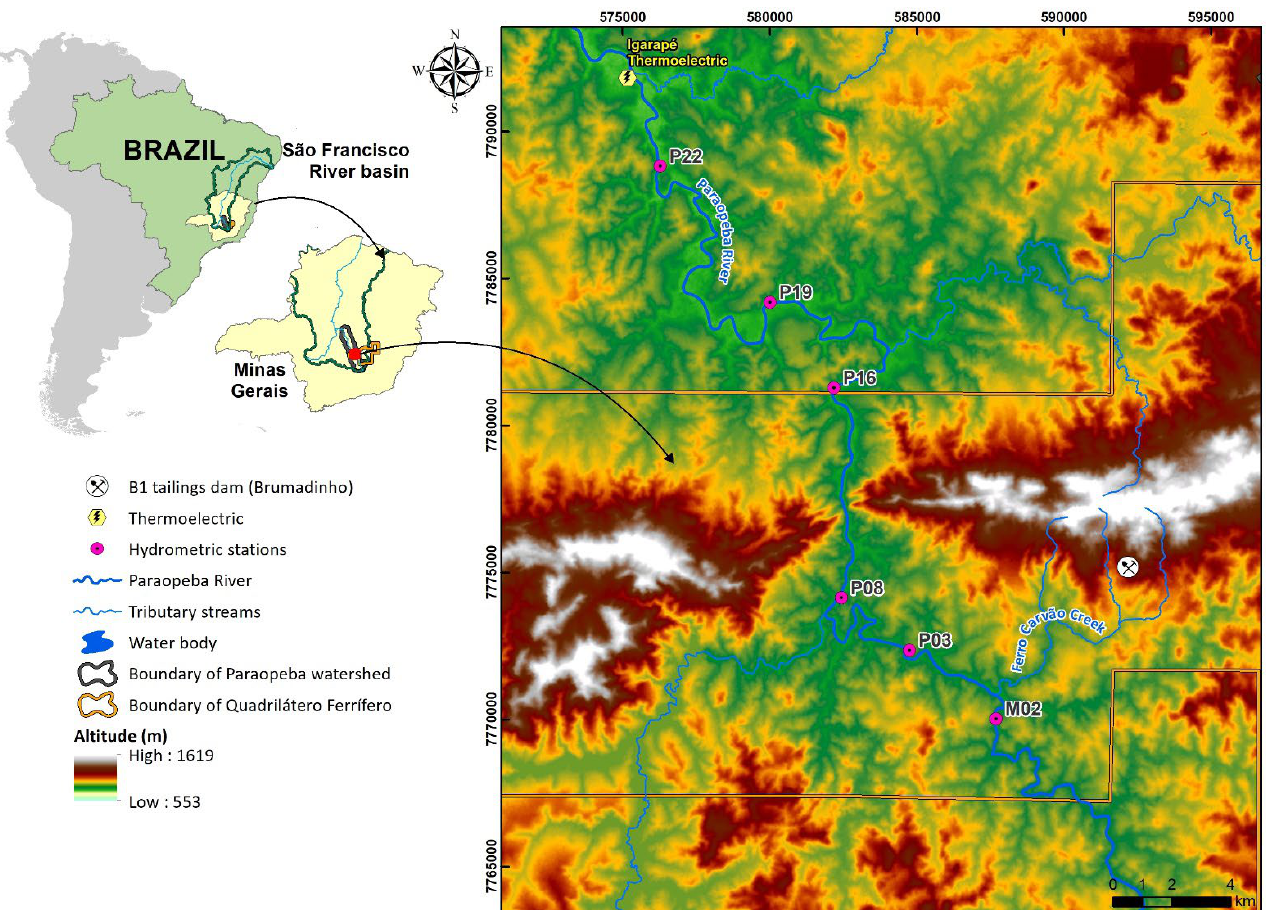
Figure 1. Hypsometric framework of Paraopeba River basin in the study area (Minas Gerais,